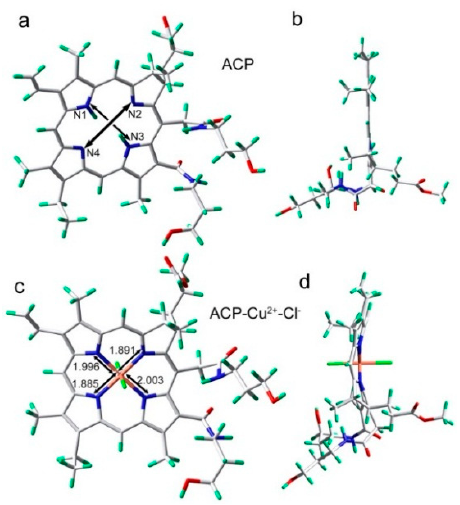
Figure 6. Energy-minimized structures by DFT calculations: ( a ) viewed from the front for ACP; ( b ) viewed from the side for ACP; ( c ) viewed from the front for ACP-Cu 2+ complex; ( d ) viewed from the side for ACP-Cu 2+ complex.